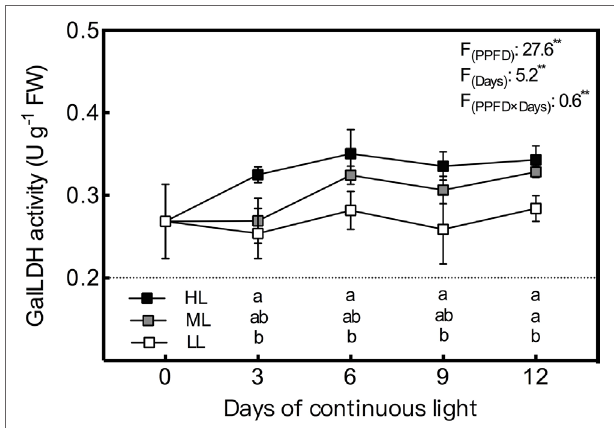
FIgURe 4 | Changes in L-galactono-1,4-lactone dehydrogenase (GalLDH) activity in lettuce leaves grown under continuous light of different intensities: low light (LL, 100 μmol·m −2 ·s −1 ), medium light (ML, 200 μmol·m −2 ·s −1 ), and high light (HL, 300 μmol·m −2 ·s −1 ). Values are means of four replicates ± SD. Different letters indicate significant differences between different light intensity treatments at p < 0.05 according to Tukey test. F values and significance of the two-way ANOVA considering the factors light intensity (PPFD), days and their interactions were given in the inset. ** indicate nonsignificant and significant at p < 0.05 and 0.01 respectively.